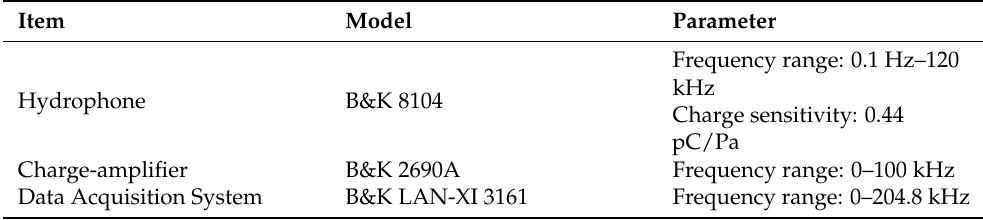
Figure 6. Layout of the propeller model, wake prosthesis and hydrophone. Table 3. Parameters of the signal collection system.